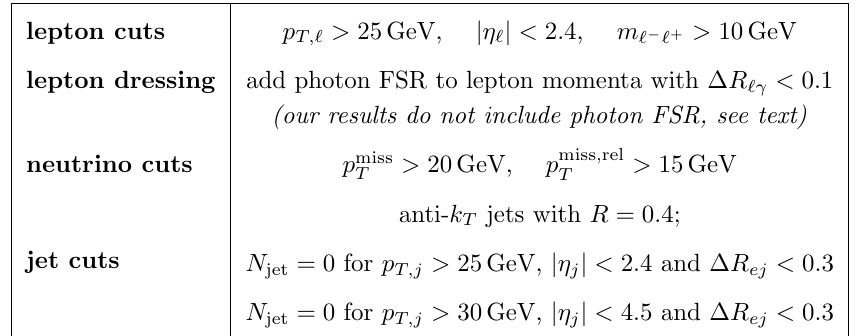
Table 1 . Fiducial cuts used in the W + W (cid:0) analysis by ATLAS at 13 TeV [9]. See text for details. of the closest lepton in the azimuthal